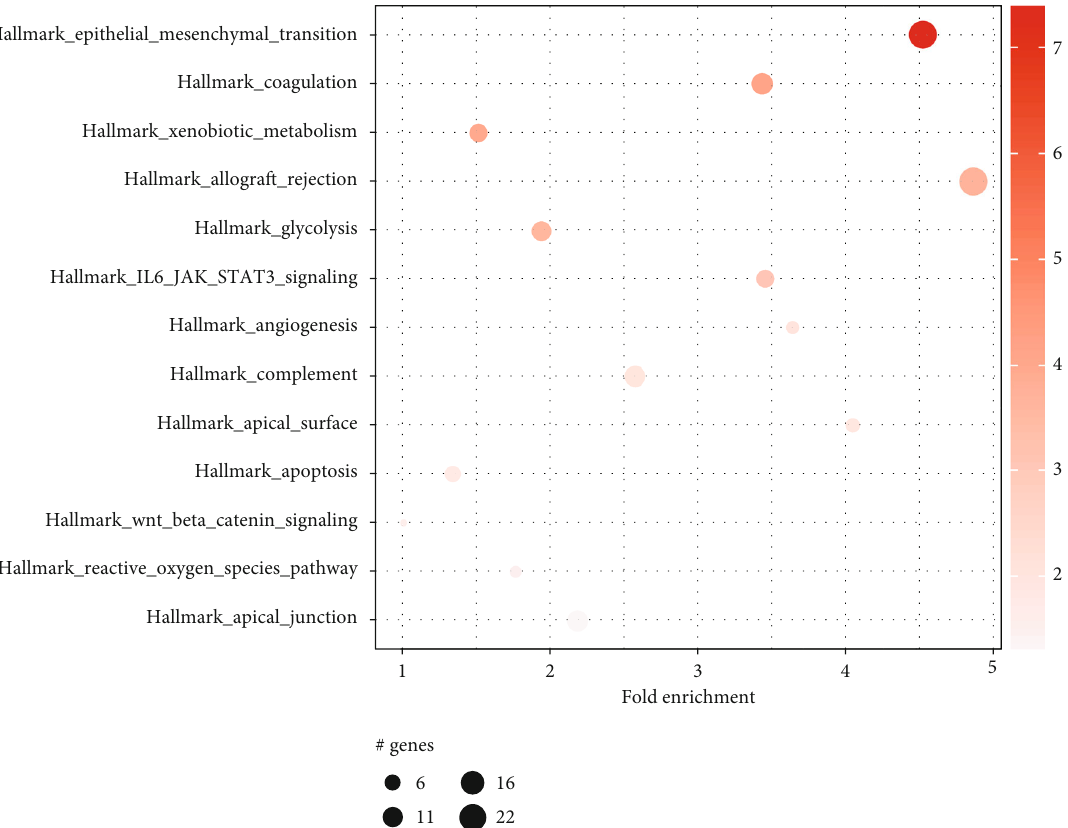
Figure 9: Gene-set enrichment analysis performed using path fi ndR and MSigDB Hallmark protein-protein interaction network. Only signi fi cantly enriched pathways ( p < 0 : 05 ) are